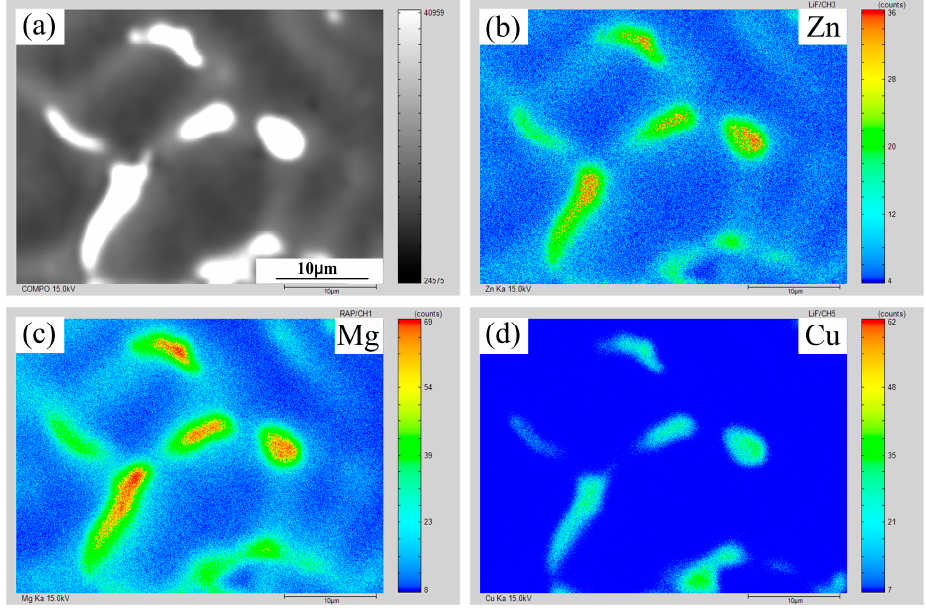
Figure 9. Elemental distribution of the weld under MIG arc mode: ( a ) secondary electron image; ( b ) distribution of Zn; ( c ) distribution of Mg; ( d ) distribution of Cu.